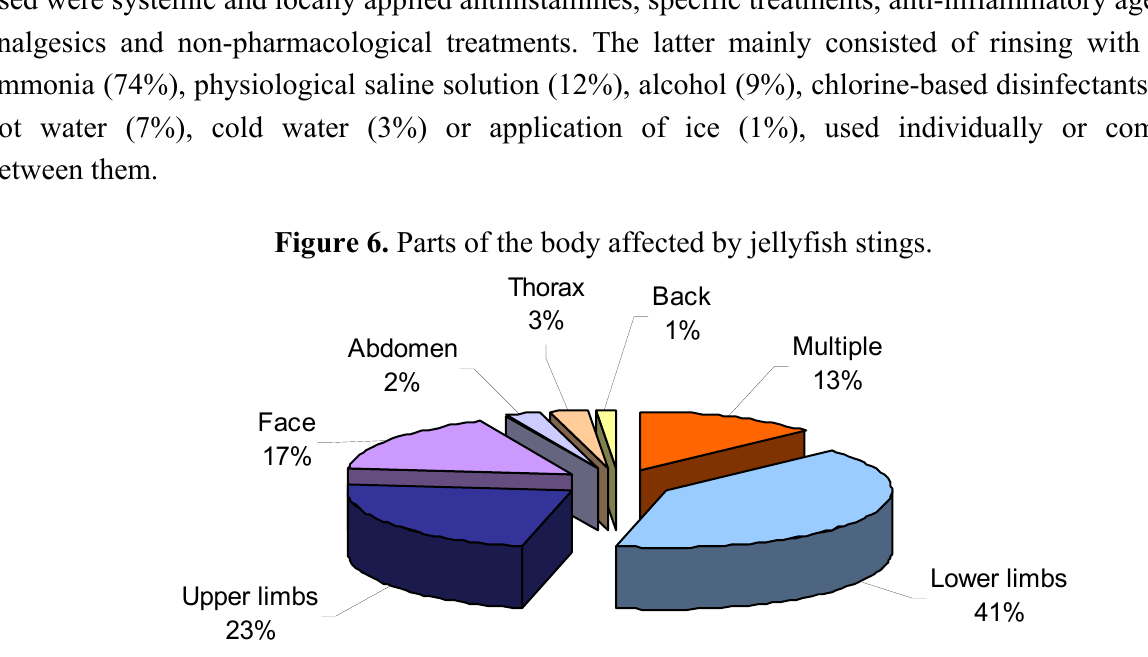
Figure 7. Medical treatments for jellyfish stings applied at first aid centres in the Salento